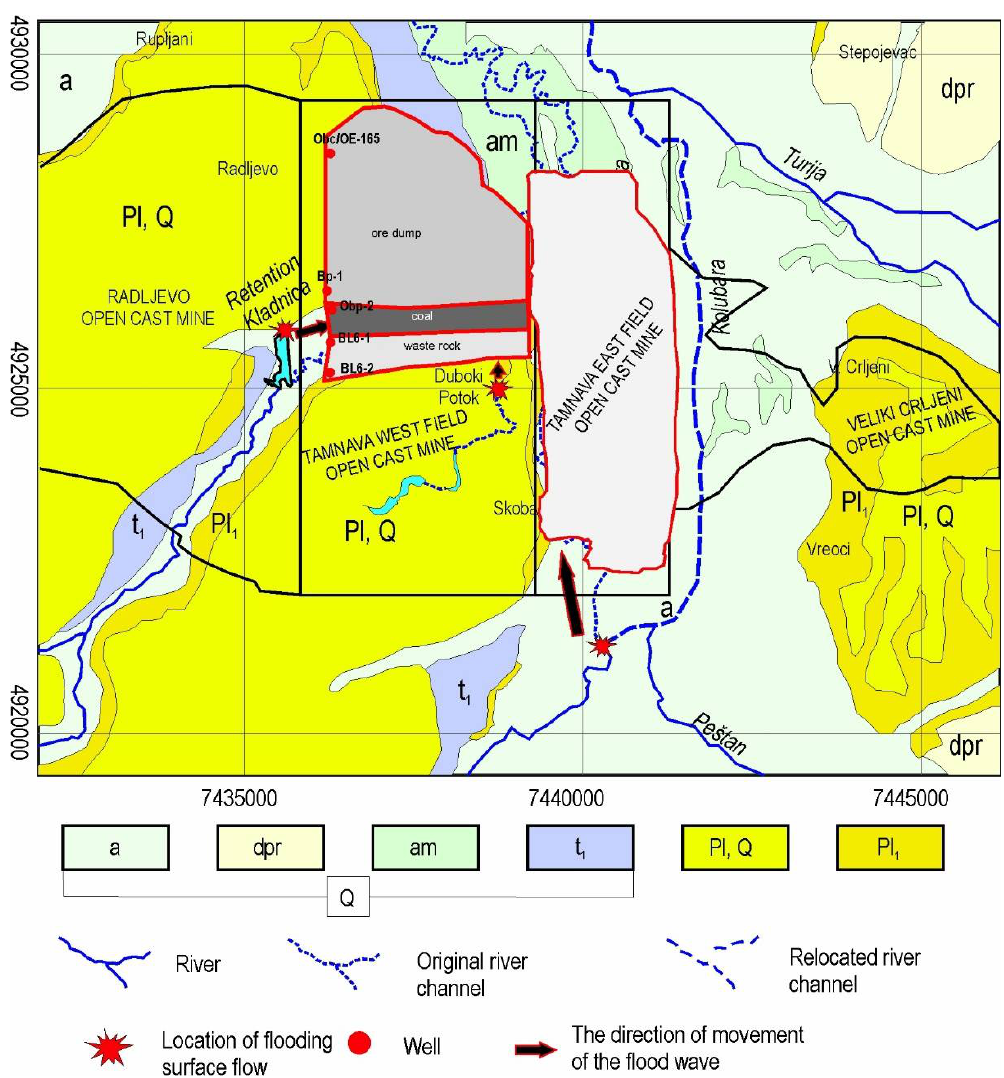
Figure 2. Geological map of the extended zone of the study area. Legend: a: bedload sediments (gravel, sand and clay); dpr—diluvial-proluvial sediments; am—oxbow sediments (clay); t 1 —lower river terrace; Pl, Q—riverine-lacustrine terrace; Pl 1 —sand and clay (marly and coaly).